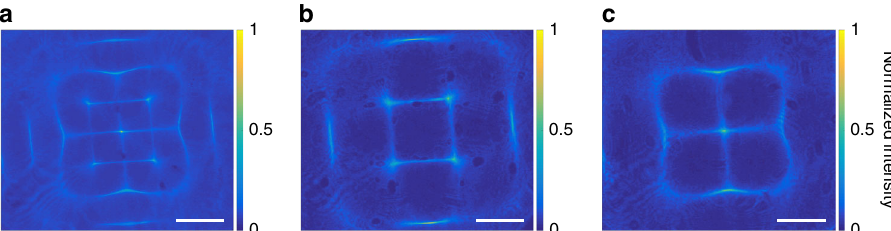
Fig. 6 High frequencies excite higher order optical modes. Six elements (1, 2, 3, 5, 6, and 7) of the eight-segment array (same as Fig. 5a) are driven at a higher frequency of f = 1.216180MHz to excite higher order modes. Experimental images showing that a continuous light (no modulation) and integration over time produces the superposition pattern ( a ) composed of the two modes in b and c . Note how the four spots around the center in b disappear and light couples instead to the center spot in c . The laser light modulation phase shift is b 0° and c 180° with respect to the ultrasound waves. The intensity of each 2D cross-section is normalized to its maximum value and the scale bar is 500 μ m